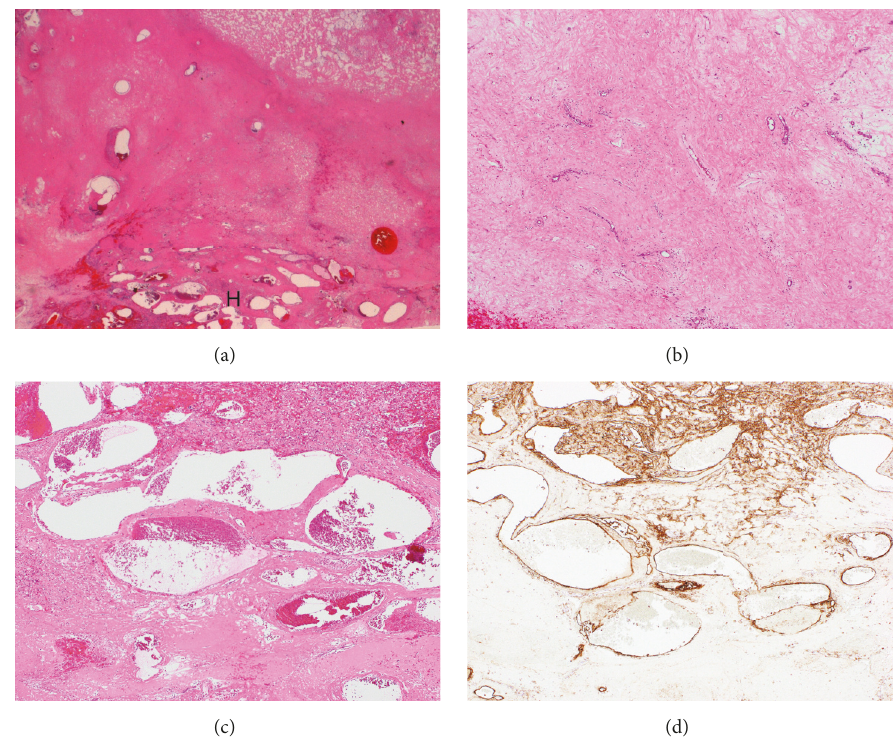
Figure 4: Histological appearances of sclerosing hemangioma. (a) Sclerotic area is manly present and cavernous hemangioma area (indicated by H) is partly observed. (Loupe image, HE stain). (b) Sclerotic area presents diffuse fibrosis. (HE stain, x40). (c) Histology of cavernous hemangioma. Note increase and dilation of medium sized veins with cavernous form in b (HE stain, x40). (d) The increased and dilated veins show positivity of CD31 immunostaining being a marker of endothelium in (c)